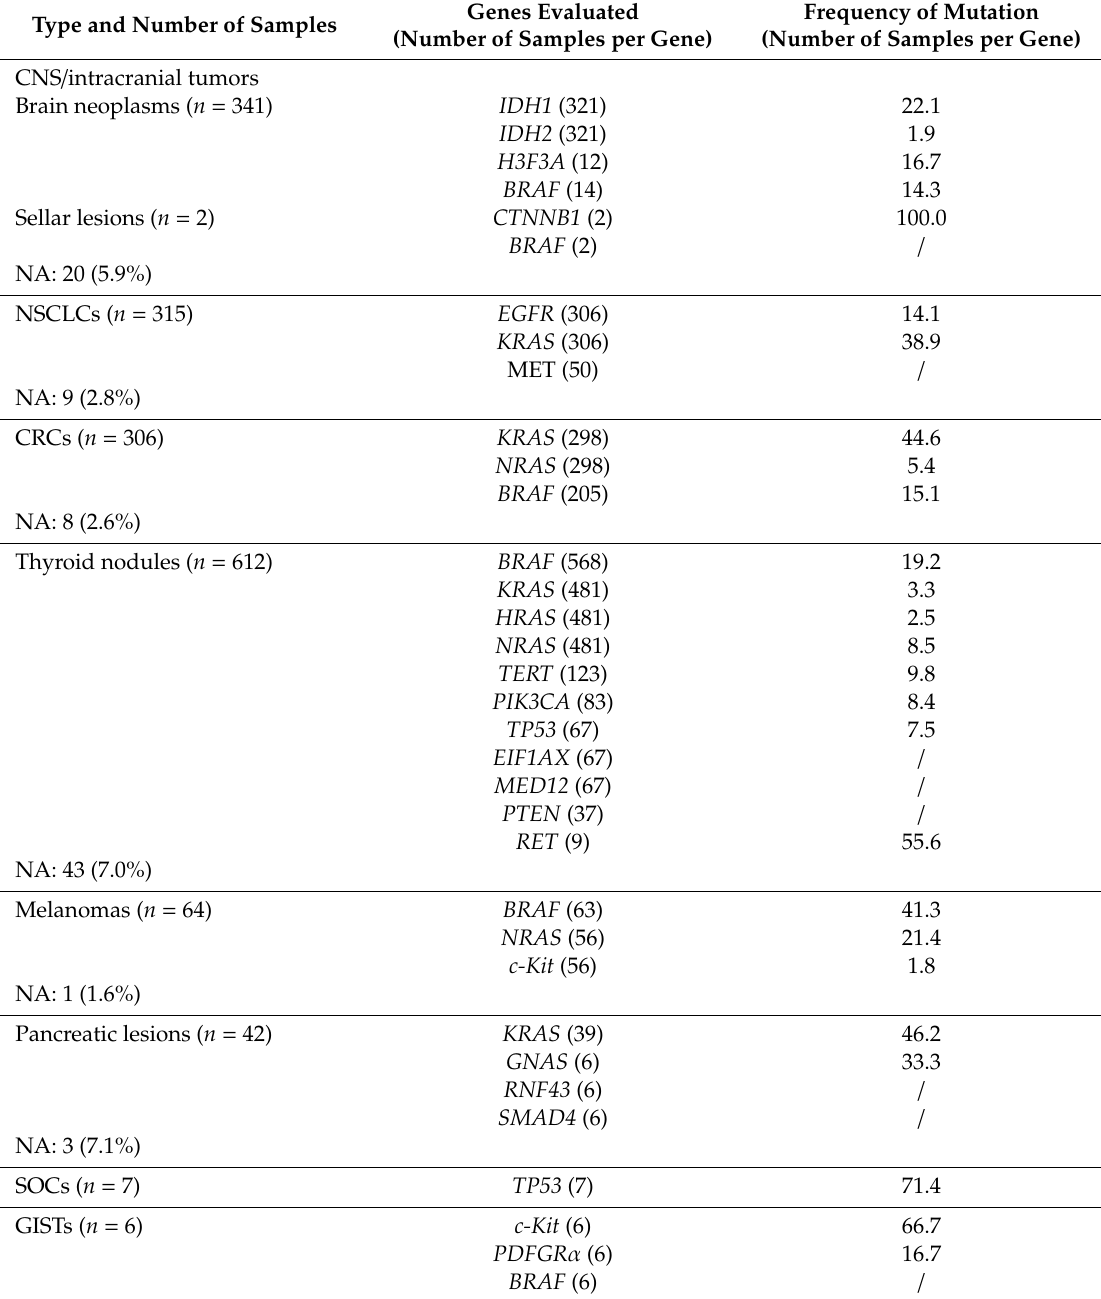
Table 4. Results of the prospective analysis of routine clinical samples with the custom-designed multi-gene